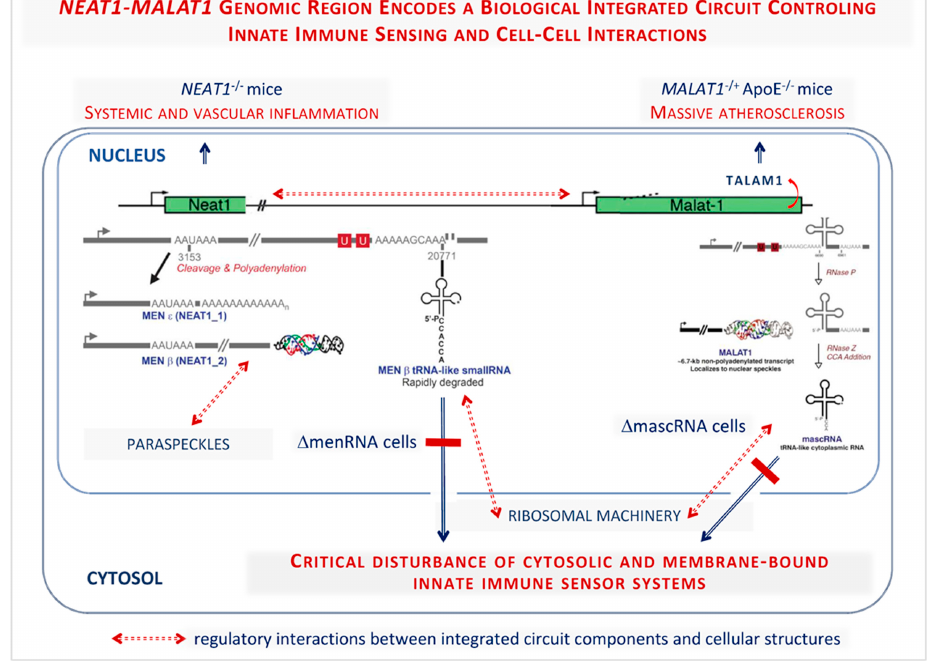
Figure 5. The NEAT1-MALAT1 genomic region encodes a biological integrated circuit controlling innate immune sensing and cell–cell interactions (reprinted from Gast et al. Cells 2022 [ 131 ] by per- mission). From an evolutionary perspective, the NEAT1-MALAT1 genomic region appears as a highly integrated RNA processing circuitry critically contributing to immune homeostasis. Its com- ponents MEN- β , MEN- ε , menRNA, MALAT1 , TALAM1 , and mascRNA are obviously set for well- balanced interactions with each other. Genetic ablation of any element therefore leads to major dys- function. Beyond prior work in NEAT1 and MALAT1 knockout mice, a recent cell biological study identified menRNA and mascRNA as novel components of innate immunity with deep impact upon cytokine regulation, immune cell–endothelium interactions, angiogenesis, and macrophage for- mation and functions. These tRNA-like transcripts appear to be prototypes of a class of ncRNAs distinct from other small transcripts (miRNAs, siRNAs) by biosynthetic pathway (enzymatic exci- sion from lncRNAs) and intracellular kinetics, suggesting a novel link for the apparent relevance of the NEAT1-MALAT1 cluster in cardiovascular and neoplastic diseases. ( Modified from ref. 131 by per- mission from Cells ). CRISPR-generated human Δ mascRNA and Δ menRNA monocytes/macrophages dis- play defective innate immune sensing, loss of cytokine control, imbalance of growth/an- giogenic factor expression impacting upon angiogenesis, and altered cell–cell interaction systems. Antiviral response, foam cell formation/oxLDL uptake, and M1/M2 polarization, are defective in Δ mascRNA and Δ menRNA macrophages, defining the tRNA-like mole- cules’ first described biological functions [131]. This CRISPR-Cas9-based cell biological study revealed that menRNA and mascRNA represent novel components of innate im- munity arising from the noncoding genome. For future translational studies, the approach to investigate menRNA and mascRNA directly suggests new avenues, since their highly dynamic levels may be more closely